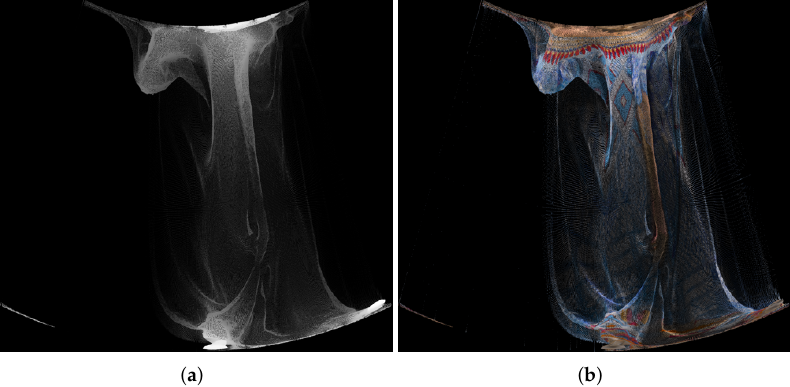
Figure 2. Panorama images created using point cloud “longdress_vox10_1060.ply” from the Albers equal-area conic projection, for the geometry ( a ) and texture ( b